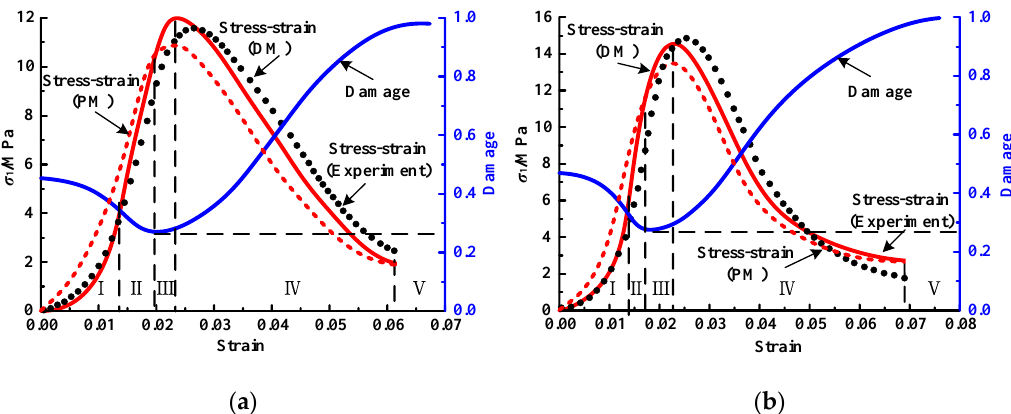
Figure 10. Comparison between experimental and theoretical curves of cement mortar: ( a ) B-1.0–2; ( b ) C-1.0–3.